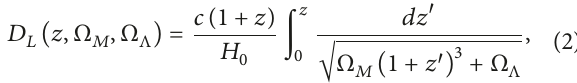
Figure 1: A sketch of the pulse displaying 𝑇 𝑇 here) and the quantities 𝑇 𝑓 and 𝑇 0 = 𝑇 𝑓 − 𝑇 pk Willingale et al. [108]; see Figure 1